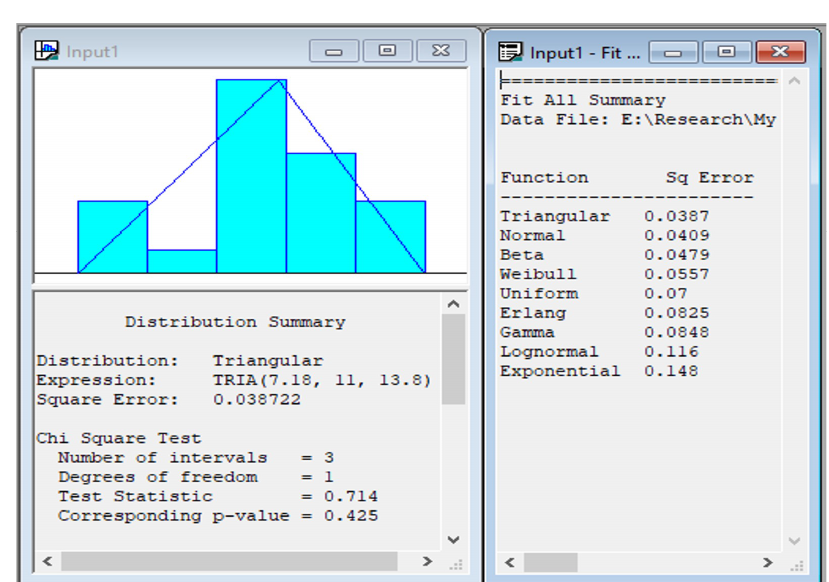
FIG. 8. DISTRIBUTION OF SERVED PATIENTS BY DOCTOR5